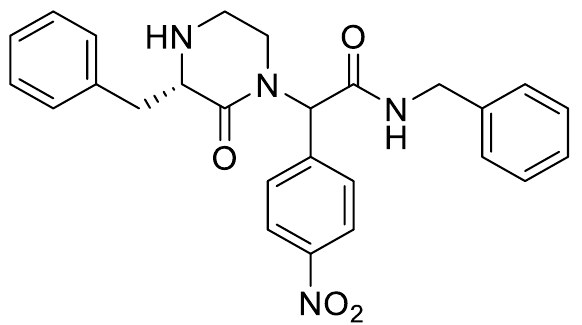
Molecules 2023 , 28 , x FOR PEER REVIEW 14 of 18 Yield: 0.078 g (31%) of amorphous solid of a mixture of two diastereomers. ESI-MS m / z = 619, [M + H] + . 1 H NMR (400 MHz, DMSO- d 6 ): δ (ppm) 8.82 (br. s., 1 H), 8.73 (br. s., 1 H), 8.25–8.15 (m, 4 H), 7.91–7.84 (m, 4 H), 7.69–7.61 (m, 4 H), 7.58 (dd, J = 5.2, 8.5 Hz, 4 H), 7.45–7.38 (m, 4 H), 7.37–7.22 (m, 14 H), 6.42–6.34 (m, 2 H), 6.26–6.20 (m, 2 H), 5.85 (d, J = 6.1 Hz, 1 H), 5.58 (d, J = 6.1 Hz, 1 H), 4.97–4.88 (m, 2 H), 4.70–4.56 (m, 2 H), 4.55–4.47 (m, 4 H), 4.43–4.38 (m, 4 H), 4.37–4.30 (m, 2 H), 3.73–3.46 (m, 4 H). HRMS (HESI-Orbitrap): m / z calcd. for C 35 H 31 N 4 O 7 [M + H] + 619.2187, found 619.2185; m / z calcd. for C 35 H 29 N 4 O 7 [M − H] − 617.2031, found 617.2042. N -Butyl-2-(3-methyl-2-oxopyrazin-1(2 H )-yl)-2-(4-nitrophenyl)acetamide 4a Yield: 0.015 g (11%) of amorphous solid. ESI-MS m / z = 345, [M + H] + . 1 H NMR (400 MHz, DMSO- d 6 ): δ (ppm) 8.71 (t, J = 5.5 Hz, 1 H), 8.29 (app d, J = 8.9 Hz, 2 H), 7.59 (app d, J = 8.5 Hz, 2 H), 7.12–7.09 (m, 1 H), 7.08–7.05 (m, 1 H), 6.65 (s, 1 H), 3.23–3.07 (m, 2 H), 2.33 (s, 3 H), 1.46–1.37 (m, 2 H), 1.26 (qd, J = 7.3, 14.8 Hz, 2 H), 0.86 (t, J = 7.3 Hz, 3 H). 13 C NMR (101 MHz, DMSO- d 6 ): δ (ppm) 165.7, 156.1, 155.0, 147.6, 142.0, 130.4, 126.0, 124.1, 121.5, 59.7, 38.7, 30.7, 20.7, 19.4, 13.5. HRMS (HESI-Orbitrap): m / z calcd. for C 17 H 21 N 4 O 4 [M + H] + 345.1557, found 345.1554; m / z calcd. for C 17 H 19 N 4 O 4 [M − H] − 343.1401, found 343.1411. N -Benzyl-2-(3-benzyl-2-oxopyrazin-1(2 H )-yl)-2-(4-nitrophenyl)acetamide